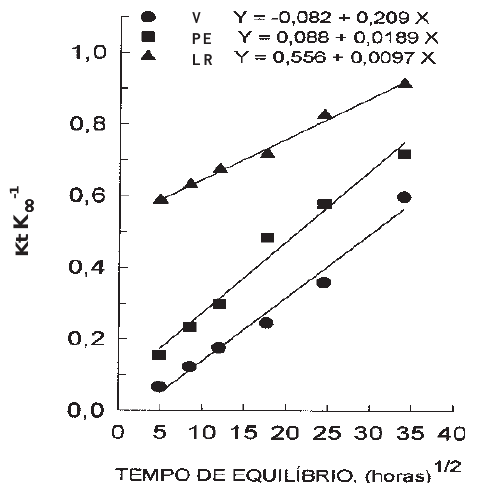
Figura 3. Cinética de liberação do potássio não- trocável dos solos, descrita pela equação parabólica de difusão (V = vertissolo, PE = podzólico vermelho-escuro, LR = latossolo